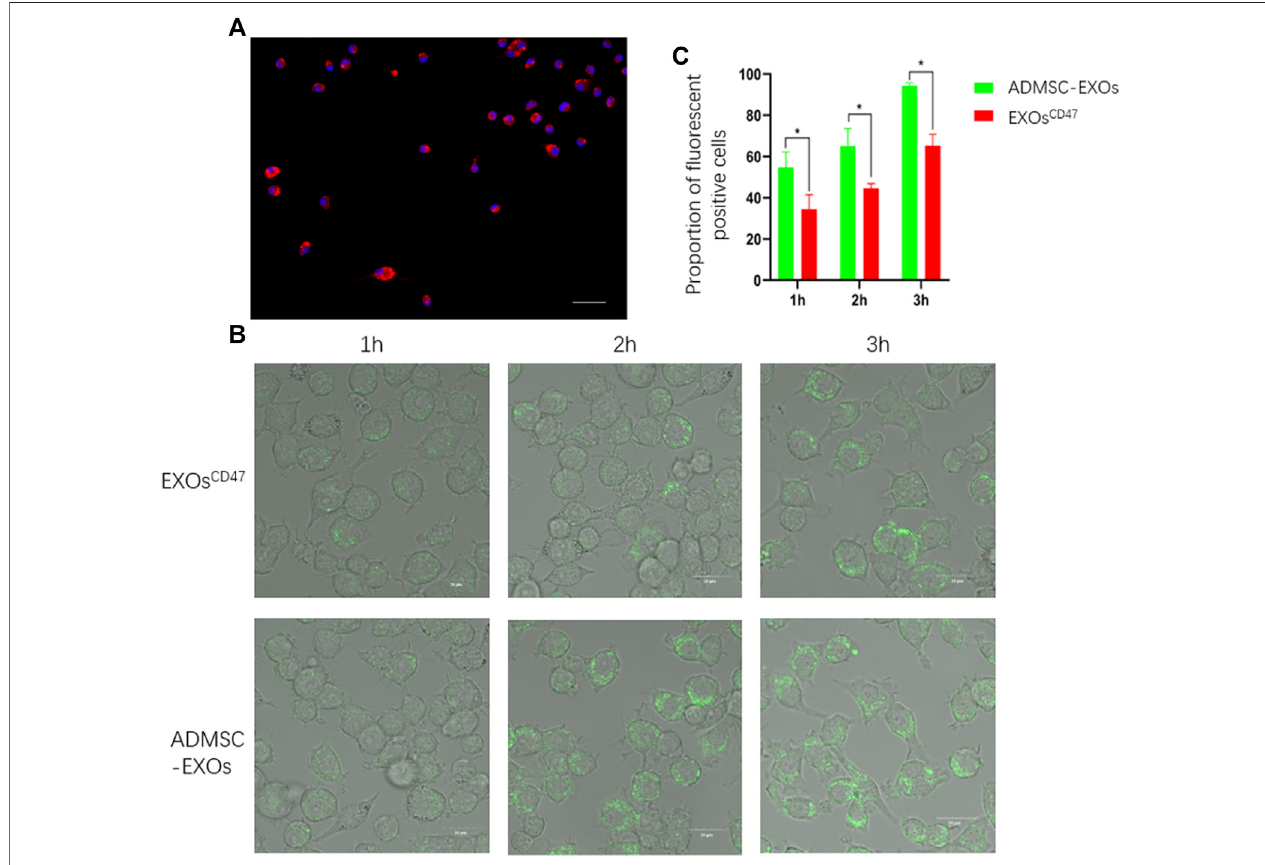
FIGURE 4 | (A) Immuno fl uorescence analysis of isolated macrophages. Blue: DAPI, Red: CD68, scale bar: 100 μ m. (B) Representative ultra-high-de fi nition laser confocal microscopy of the phagocytosis of EXOs from the ADMSC-EXOs (control) and EXOs CD47 groups after 1, 2, and 3 h scale bar: 20 μ m. (C) . Quantitation of the results in Figure 4B . * p < 0.05, n =